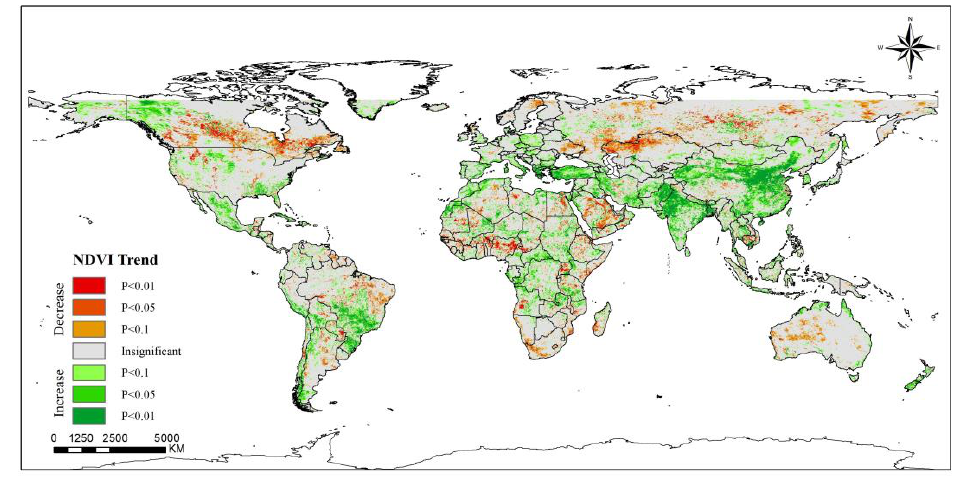
Figure 4. Spatiotemporal trends of NDVI worldwide (2000 – 2019).